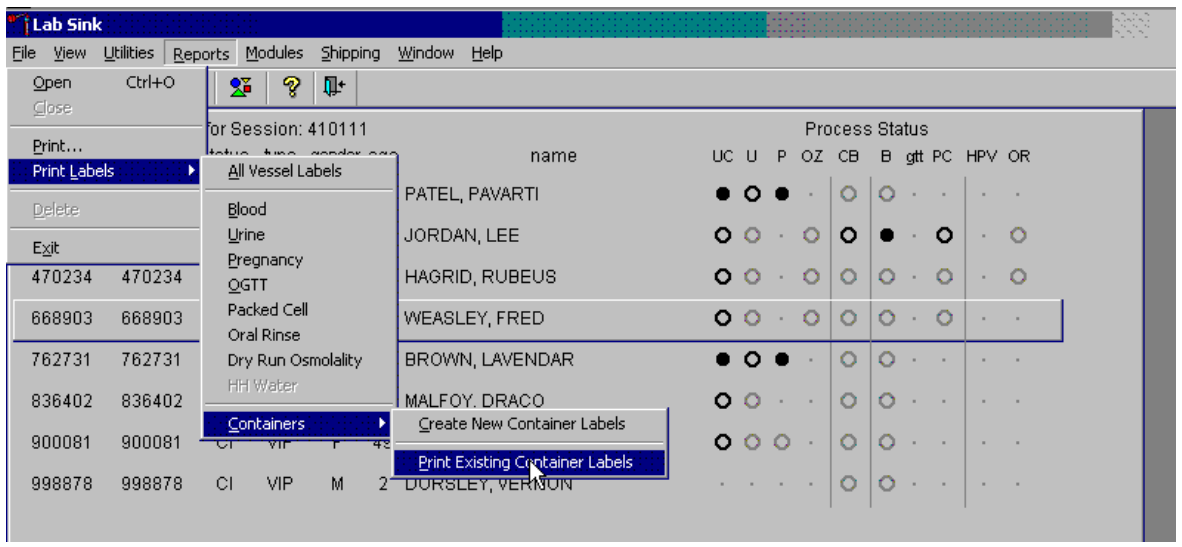
Reprint labels for existing, not shipped